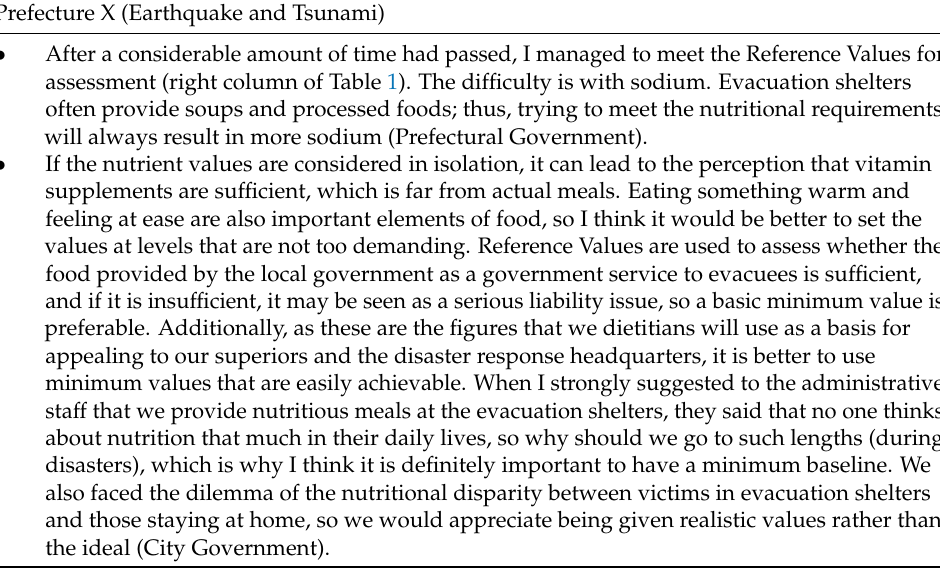
Table 7. Types and values of nutrients covered. (Q4 and